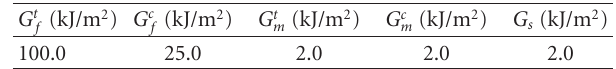
Table 3: Intralaminar fracture toughnesses.